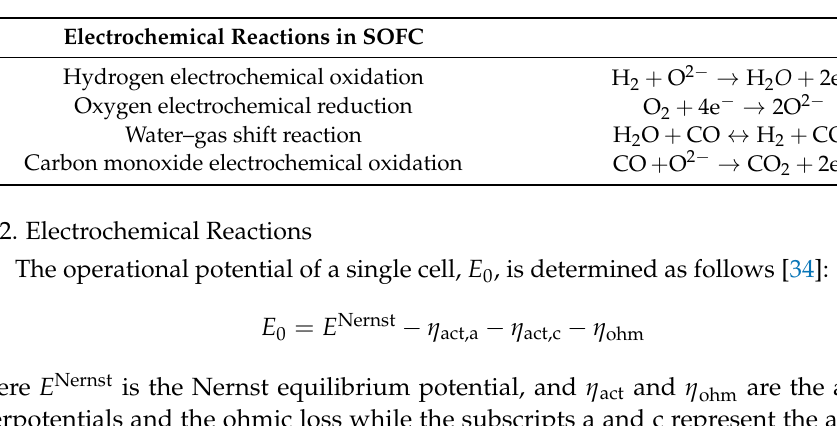
Table 2. A summary of the reactions in the tubular